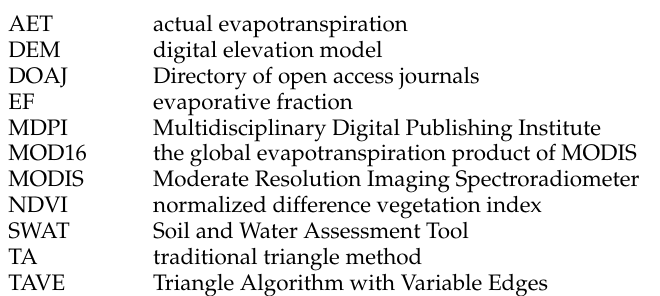
Table S1: Summary of studies that addressed the terrain effects in temperature-vegetation triangle methods; Figure S1: The relationship between annual average air temperature and elevation based on 14 ground weather stations; Figure S2: The percentage of cloud-free pixels in T s images in 2009; Figure S3: Comparison of the AET estimates derived by TA and MOD16 over the study area on nine selected DOYs; Figure S4: Comparison of the AET estimates derived by TAVE and MOD16 over the study area on nine selected DOYs; Figure S5: Comparison of satellite-derived PET estimates with pan evaporation observations at four stations; Figure S6: Comparison of satellite-derived AET estimates with pan evaporation observations at four stations; Figure S7: Sensitivity of AET estimates to TAVE